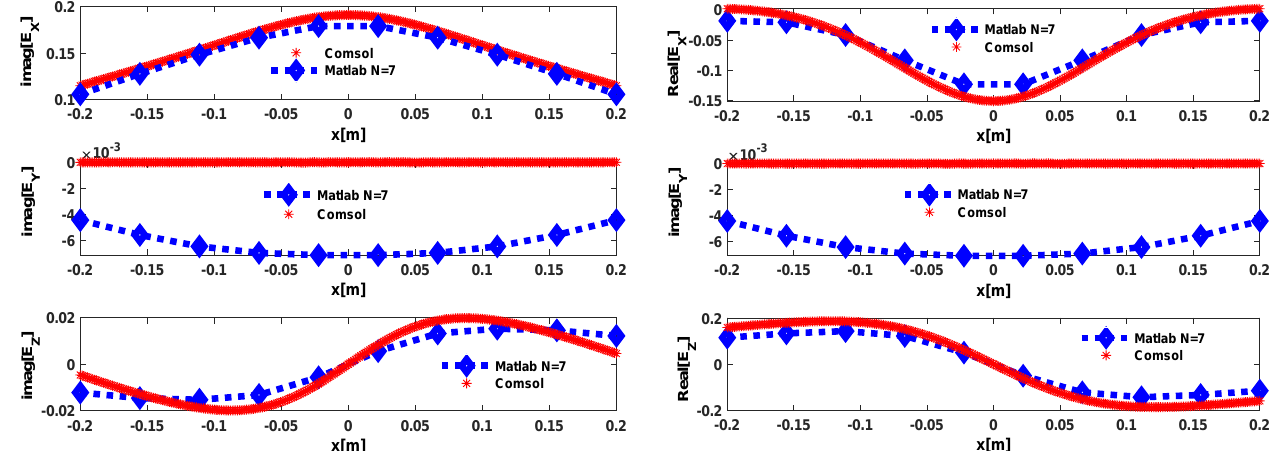
Figure 5. Real part ( left ) and imaginary part ( right ) of the scattered electric field by two PEC spheres. In particular, Matlab results (blue color dot lines) are perfectly super-imposed on Comsol results (red marker color lines). Sphere I and sphere II are translated at 0.5 m and − 0.5 m along z -axis, and the selected frequency is f = 0.3